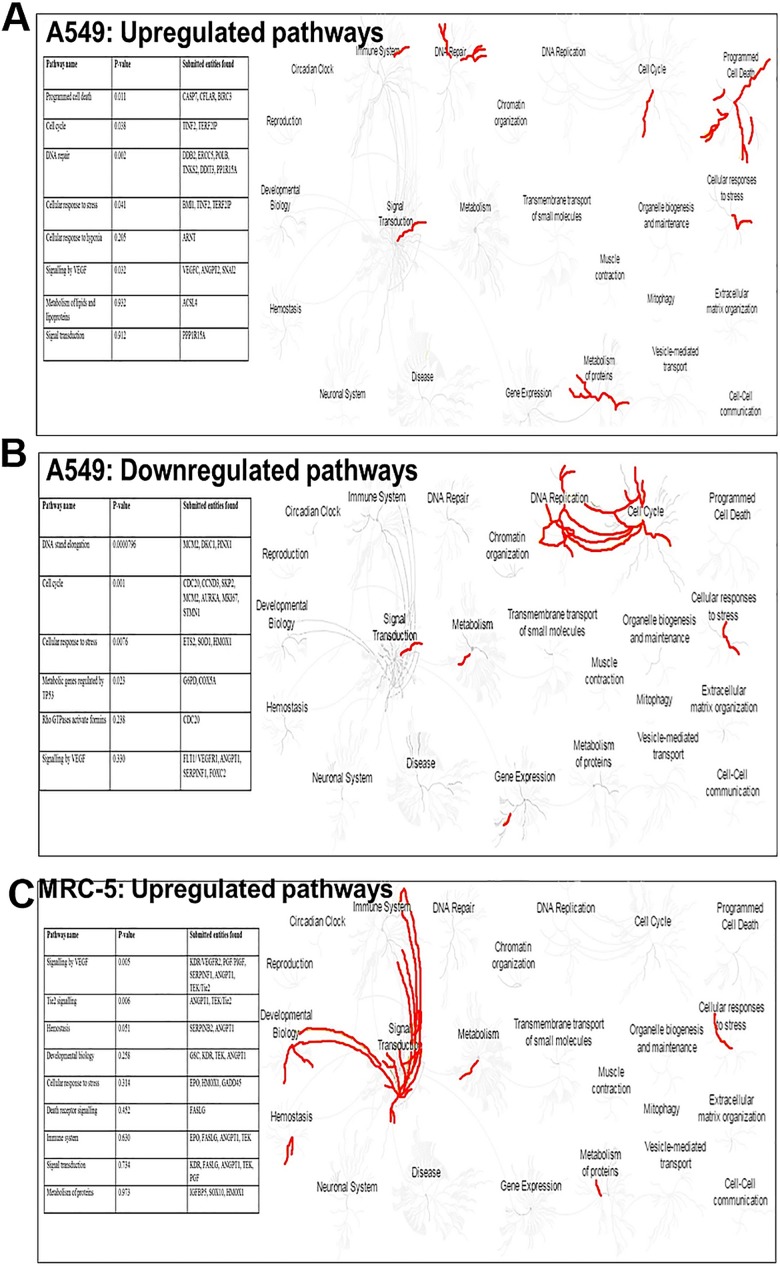
Methyl pyruvate upregulates pro-survival and anti-apoptotic genes in MRC-5 fibroblasts and contrasting genes in A549 cancer cells.The RT2 ProfilerTM PCR array Human Cancer PathwayFinderTM was used to analyse differential expression of 84 cancer-related genes in response to treatment with methyl pyruvate and irinotecan for 48 hours. Gene expression in treated cells was compare with expression in corresponding cells, thus four experiments were conducted. (a) The Venn diagram summarizes differentially expressed genes in A549 and MRC-5 cells. (b) Using PANTHER the differentially expressed genes were further analysed to reveal biological pathways that were affected when the A549 and MRC-5 cells are treated with irinotecan and methyl pyruvate. Uniquely expressed genes were used as input into PANTHER to identify perturbed biological pathways. The Hidden Markov statistical model (HMM) was used to assign genes from the query list to their corresponding biological pathways. (c) The GeneMANIA module in Cytoscape (version 3.3.0) was applied to construct interaction networks in each cell line. The Networks represent upregulated and downregulated gene sets after treatment with both drugs for 48 hours. Genes in the submitted query list are indicated as circular nodes while those predicted to be related are displayed as diamond nodes (<>). Pathway categories received a score weight when the pathways data sets in GeneMANIA link to members of the query list. The edges (coloured lines) that connect neighbouring genes are depicted as follows: medium purple: Co-expression, medium turquoise: pathway; brown: physical interaction; blue: co-localization; khaki:shared protein domains; maroon: genetic interactions; green: predicted. Interactions were considered statistically significant when q < 0.05. A q-value of 0.05 indicates that there is a 5% chance of getting a false statistically significant result. The q-values were estimated by the in-built Benjamini-Hochberg procedure.